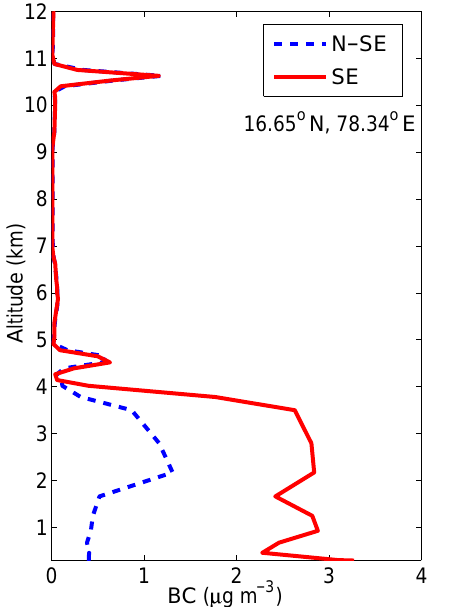
Figure 5. Model-simulated vertical profile of BC on 17 March 2010 for N-SE runs (model simulations without prescription of surface level anthropogenic BC emissions) and SE configurations (model simulations with prescription of surface level anthropogenic BC emissions).